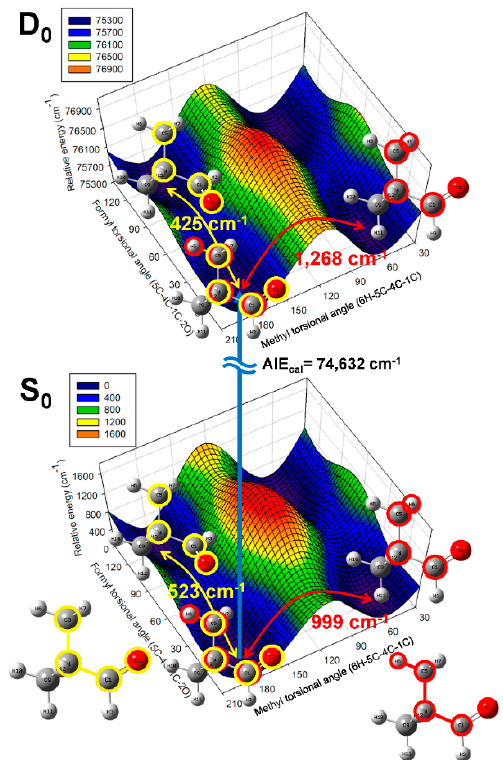
Figure 2. 2D PESs of pivaldehyde in S 0 and D 0 states constructed as functions of dihedral angles associated with formyl and methyl torsional motions, describing conformational interconversion performed by optimizing the remaining geometric parameters at ω B97XD/cc-pVTZ level. Eclipsed- pivaldehyde conformer with C S symmetry, which can be interconverted via three-fold internal rotations for formyl or methyl groups, exists at global minimum on both S 0 and D 0 states. AIE cal denotes the AIE calculated for conformer with zero-point energy correction.